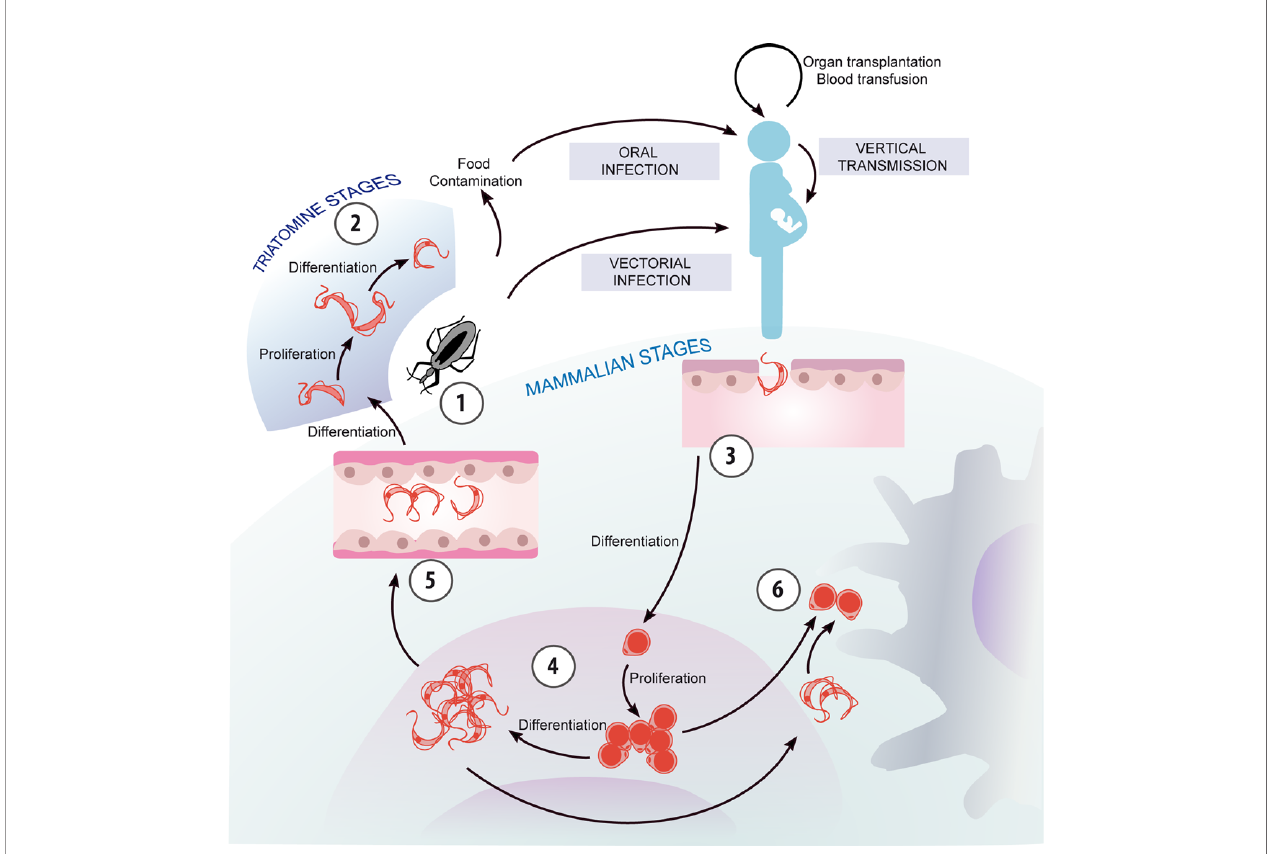
FIGURE 1 | Chagas disease transmission and parasite life cycle. The life cycle of T. cruzi can be conceptualized with its beginning at moment when the triatomine vector ingests bloodstream trypomastigotes from an infected mammalian host, which differentiate into replicative epimastigotes (1). Epimastigotes migrate to the hindgut and differentiate into non-replicative, infectious metacyclic trypomastigotes (2), which are excreted with the feces of the vector and are ready to infect a new mammalian host. Additionally, T. cruzi can be transmitted through other routes than vectorial spread, such as mother-to-child and oral transmission besides blood transfusion and organ transplantation. Trypomastigotes invade host cells and differentiate into the intracellular, replicative amastigote form (3), which can also transform into trypomastigotes (4). These are released when the host cells break down, and may invade new cells, migrate through the bloodstream, or be ingested by a vector (5). In addition, extracellular amastigotes, originated by the premature rupture of the host cell or by extracellular trypomastigote differentiation, can be engulfed by macrophages